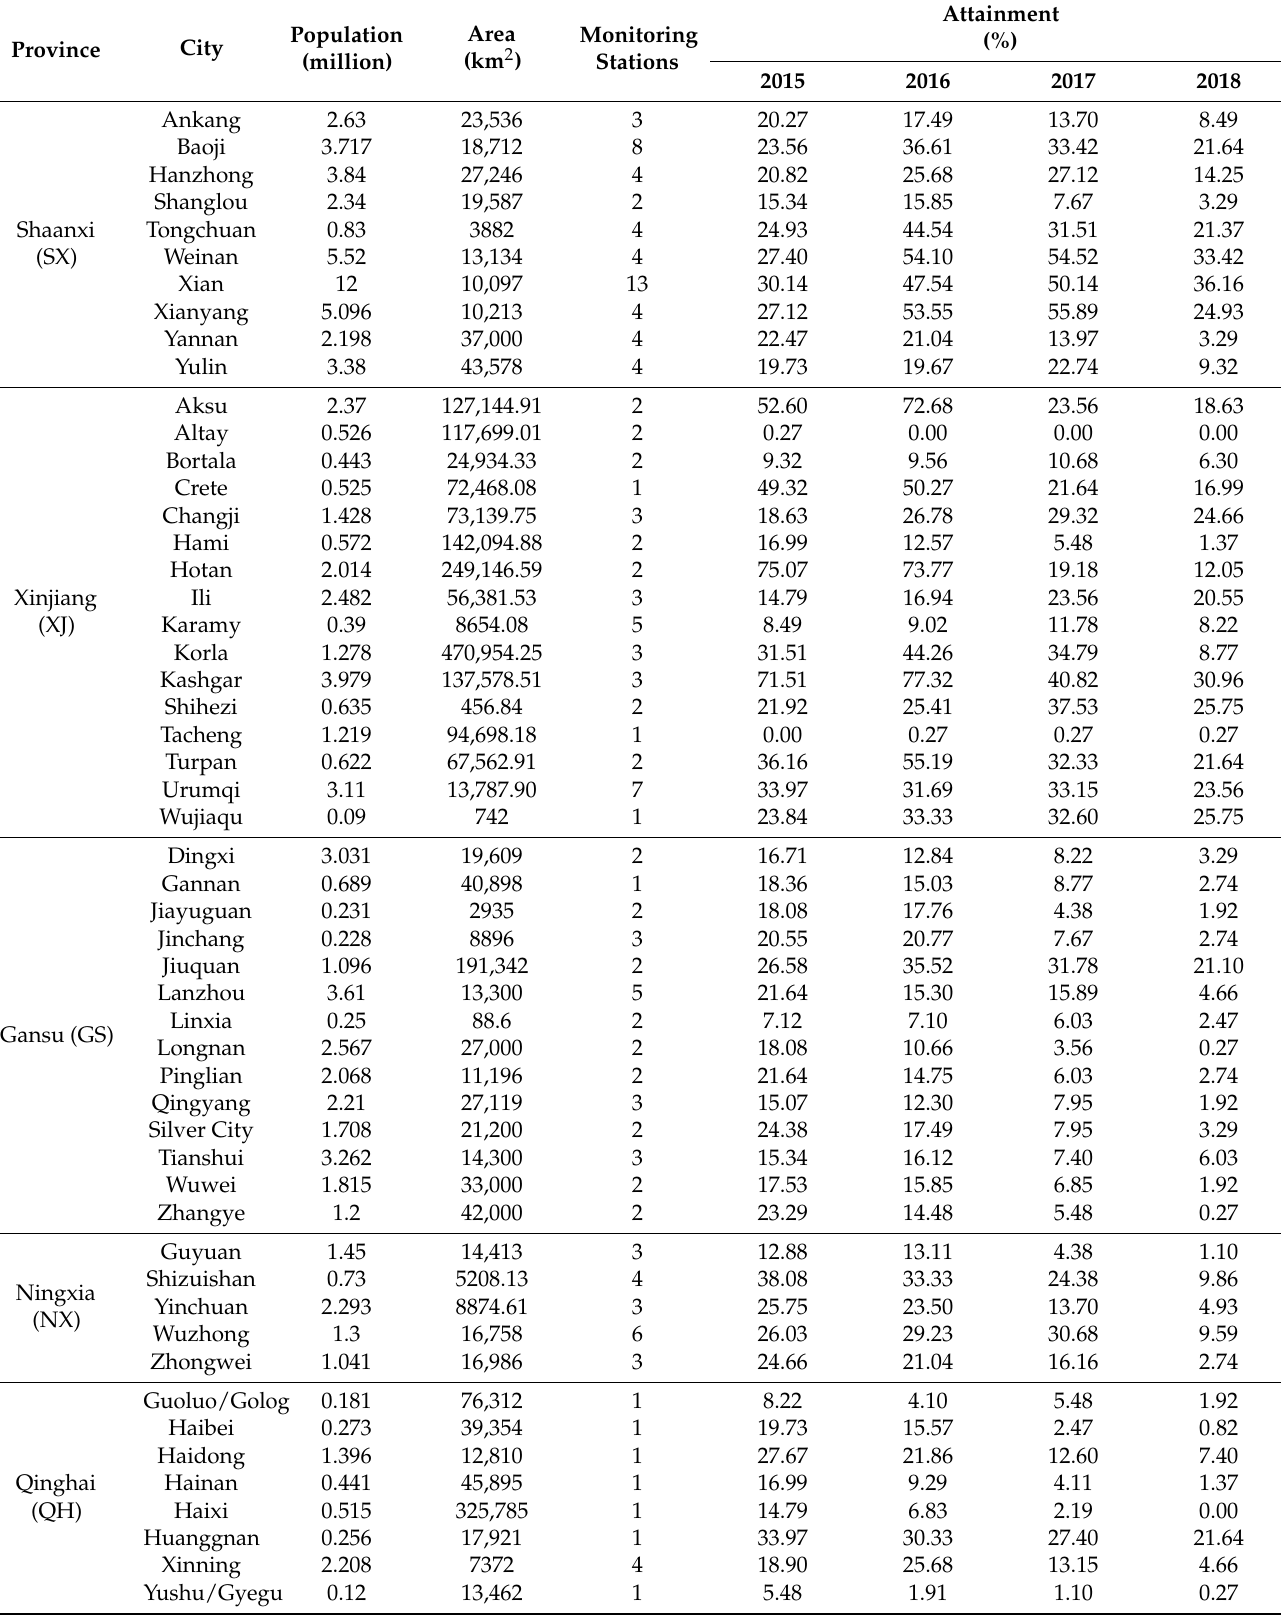
Table 1. Description of cities under observation in five provinces (Shaanxi (SN), Xinjiang (XJ), Gansu (GS), Ningxia (NX), and Qinghai (QH)) of northwest China